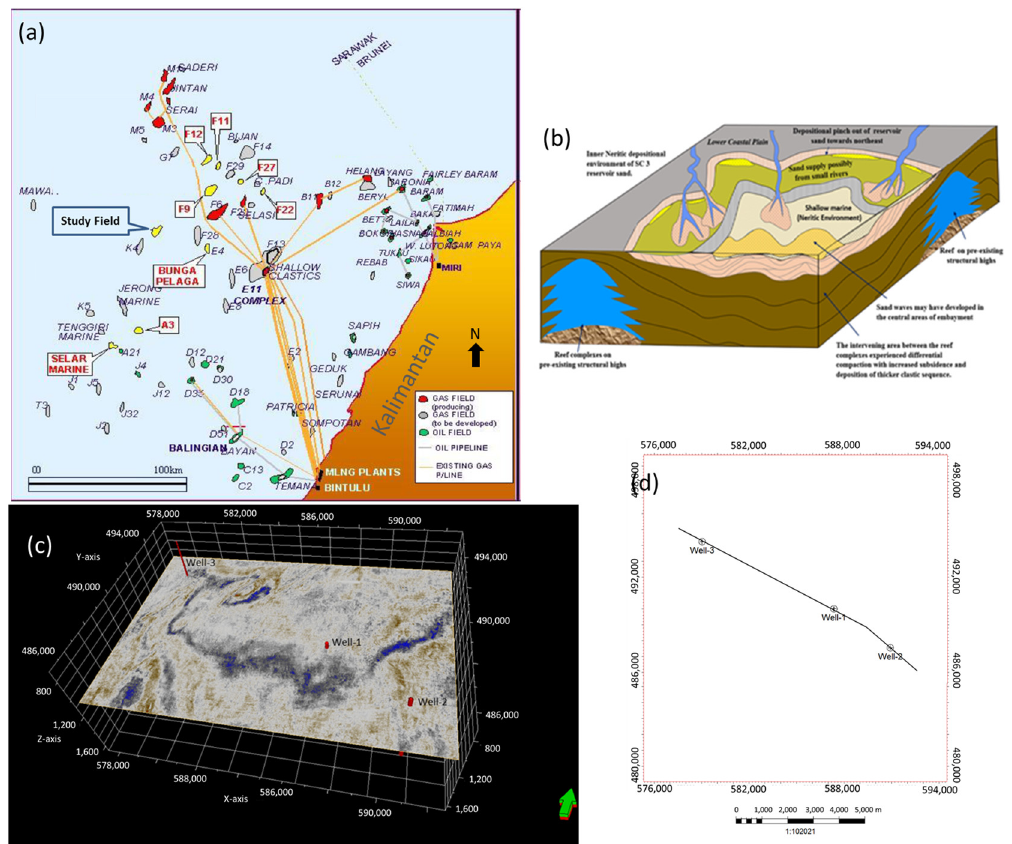
Figure 1. Study Field, ( a ) Field location, ( b ) Schematic diagram showing the major SC3 reservoir depositional model in study area, ( c ) 3D seismic survey grid showing three well locations and seismic time slice at 1000 ms two-way time depth, ( d ) Seismic survey map view showing the position of three available wells.